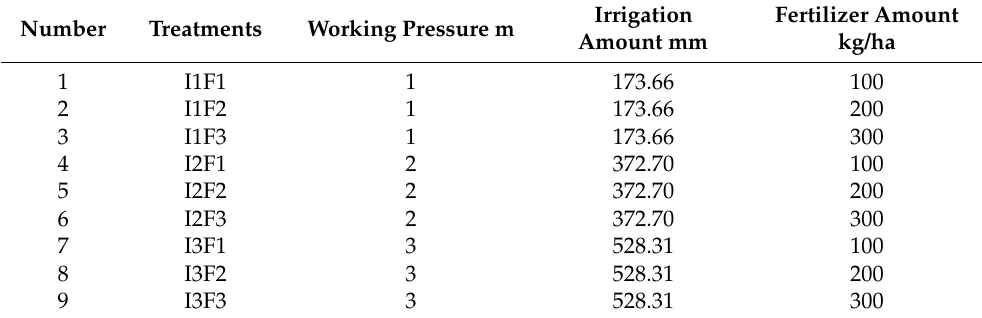
Table 1. Test treatment